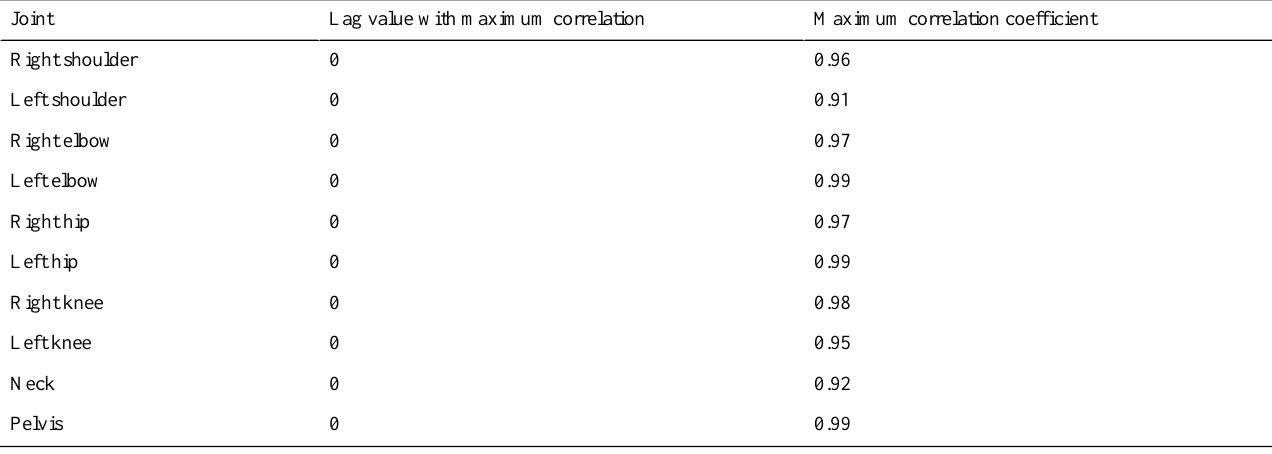
Table 2. Maximum cross-correlations of Lindera-v2 and reference standard values.